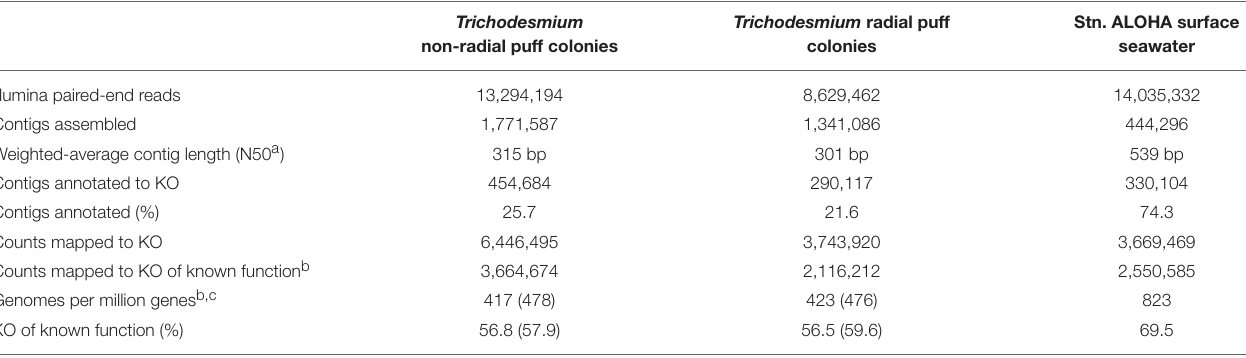
TABLE 2 | Summary of metagenome assembly, annotation, and